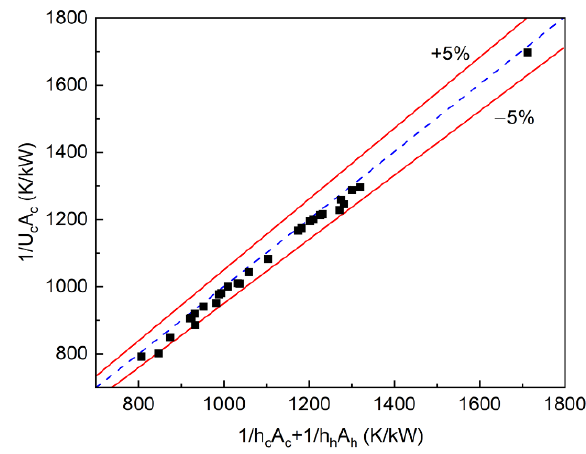
Figure 5. The verification of the thermal resistance analysis method.